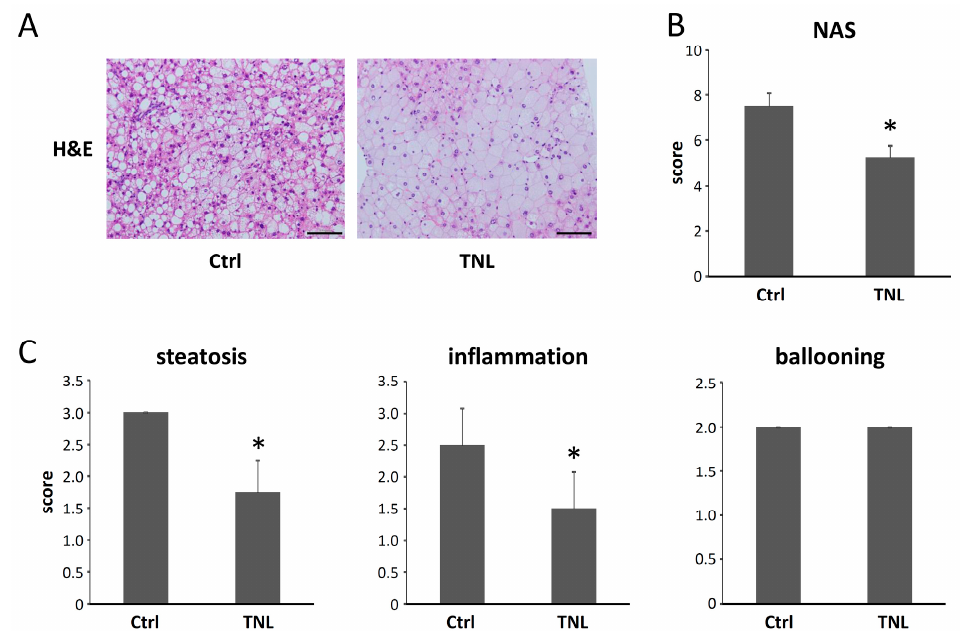
Figure 1. Effects of teneligliptin on hepatic histopathology in experimental mice. ( A ) Hematoxylin and eosin (H&E) staining of liver sections from experimental mice. Representative photomicrographs of the liver sections of MSG/high-fat diet (HFD)-administered mice treated with or without teneligliptin. Bar, 100 µ m; ( B , C ) The NAFLD activity score (NAS) was determined based on histopathological analysis (steatosis, inflammation and ballooning). Ctrl, control. TNL, teneligliptin. The values are expressed as the mean ± SD. * p < 0.05 versus the control group.